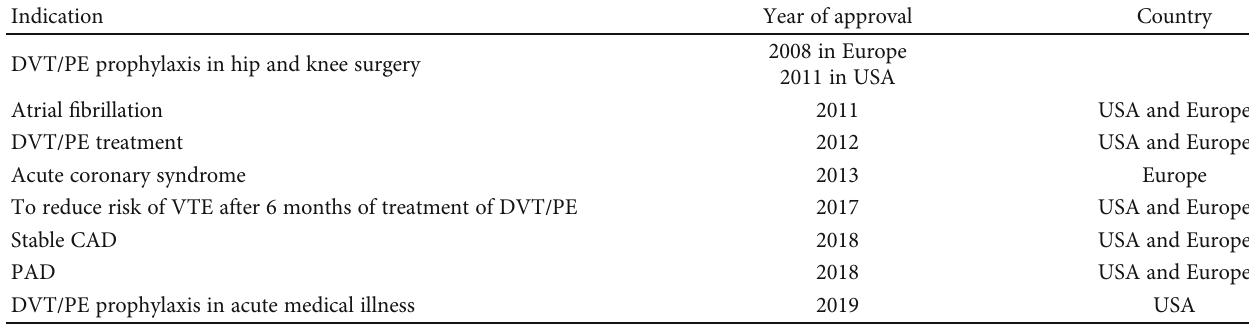
Table 1: Indications and approval of